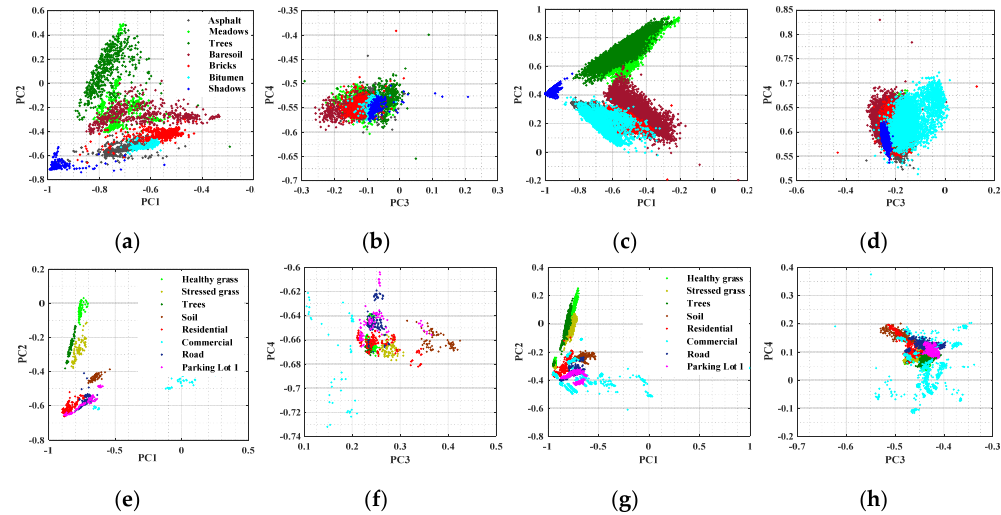
Figure 4. Principal component scatter plots of the source and target images for Pavia (University: ( a ) PC1 vs. PC2; ( b ) PC3 vs. PC4; Center: ( c ) PC1 vs. PC2; ( d ) PC3 vs. PC4 and Houston Left: ( e ) PC1 vs. PC2; ( f) PC3 vs . PC4; Right: ( g ) PC1 vs. PC2; ( h ) PC3 vs. PC4.) data sets.